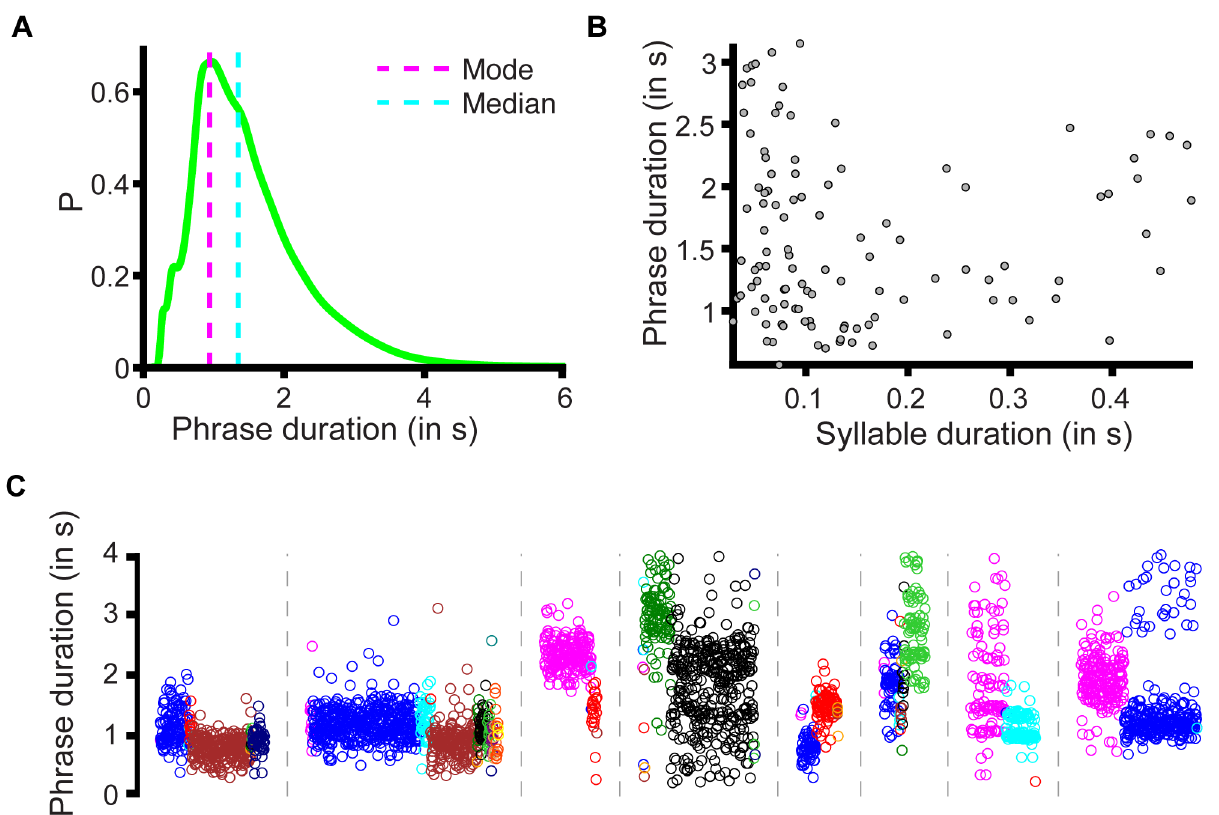
Figure 2. Phrase length is defined by a typical time-scale and depends on context. A, Probability density of phrase durations for all 6 birds (mode=.9416, .8132–1.407 95% bootstrap confidence interval, median=1.3482, 1.3375–1.3589). B, A scatter plot of phrase duration plotted against syllable duration for 6 birds reveals no general correlation between phrase length and syllable length (r=.013,p=.90). C, Examples of the effect of phrase context on phrase duration. Each group of points (separated by dotted lines) indicates the duration of a different phrase type, while the colors (arbitrary) indicate different preceding phrase types. (These examples draw from all 6 birds, all phrase durations are given in Fig. S12 ).